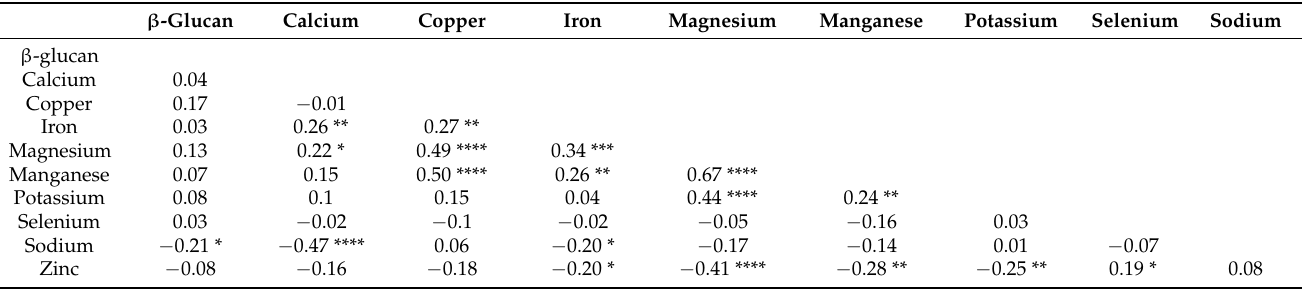
Table 7. Correlations among β -glucan and micronutrients contents of Hordeum spontaneum of single plant seeds derived